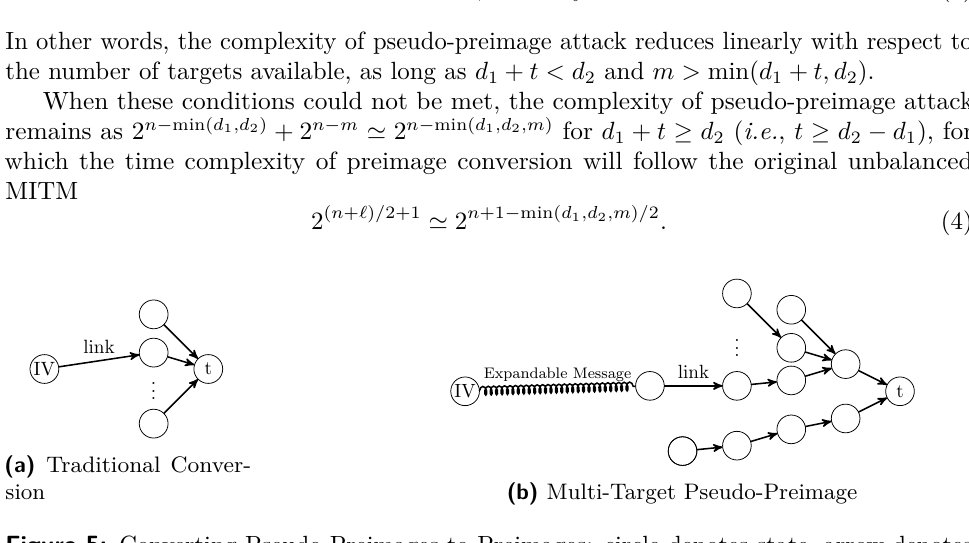
Figure 5: Converting Pseudo-Preimages to Preimages: circle denotes state, arrow denotes message block